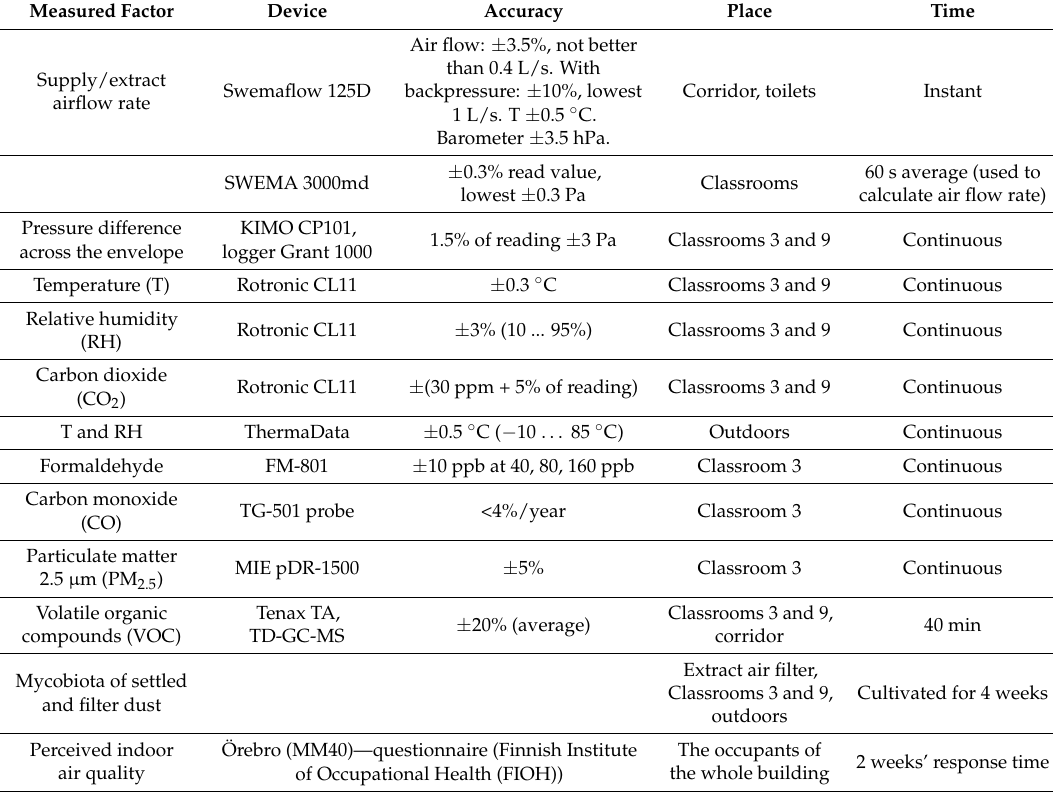
Table 2. Measurement methods, devices and their accuracy, measurement place and